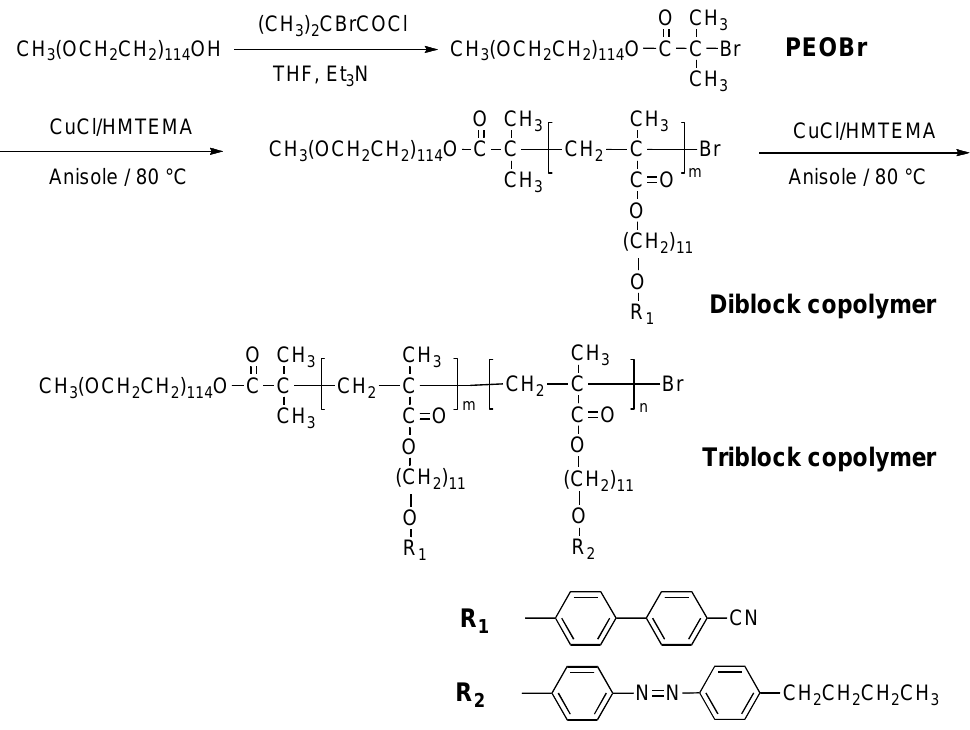
Figure 3. Preparation of amphiphilic PRBCs by a modified ATRP